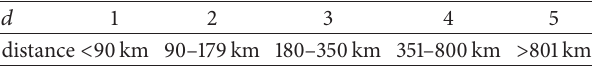
Table 3: Segmentation of the